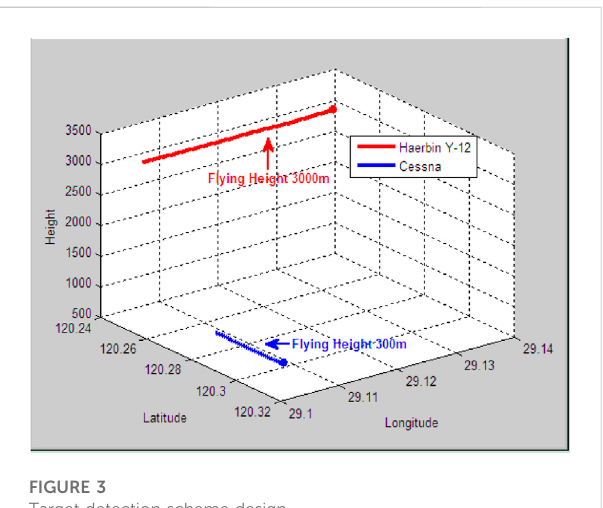
FIGURE 3 Target detection scheme design.